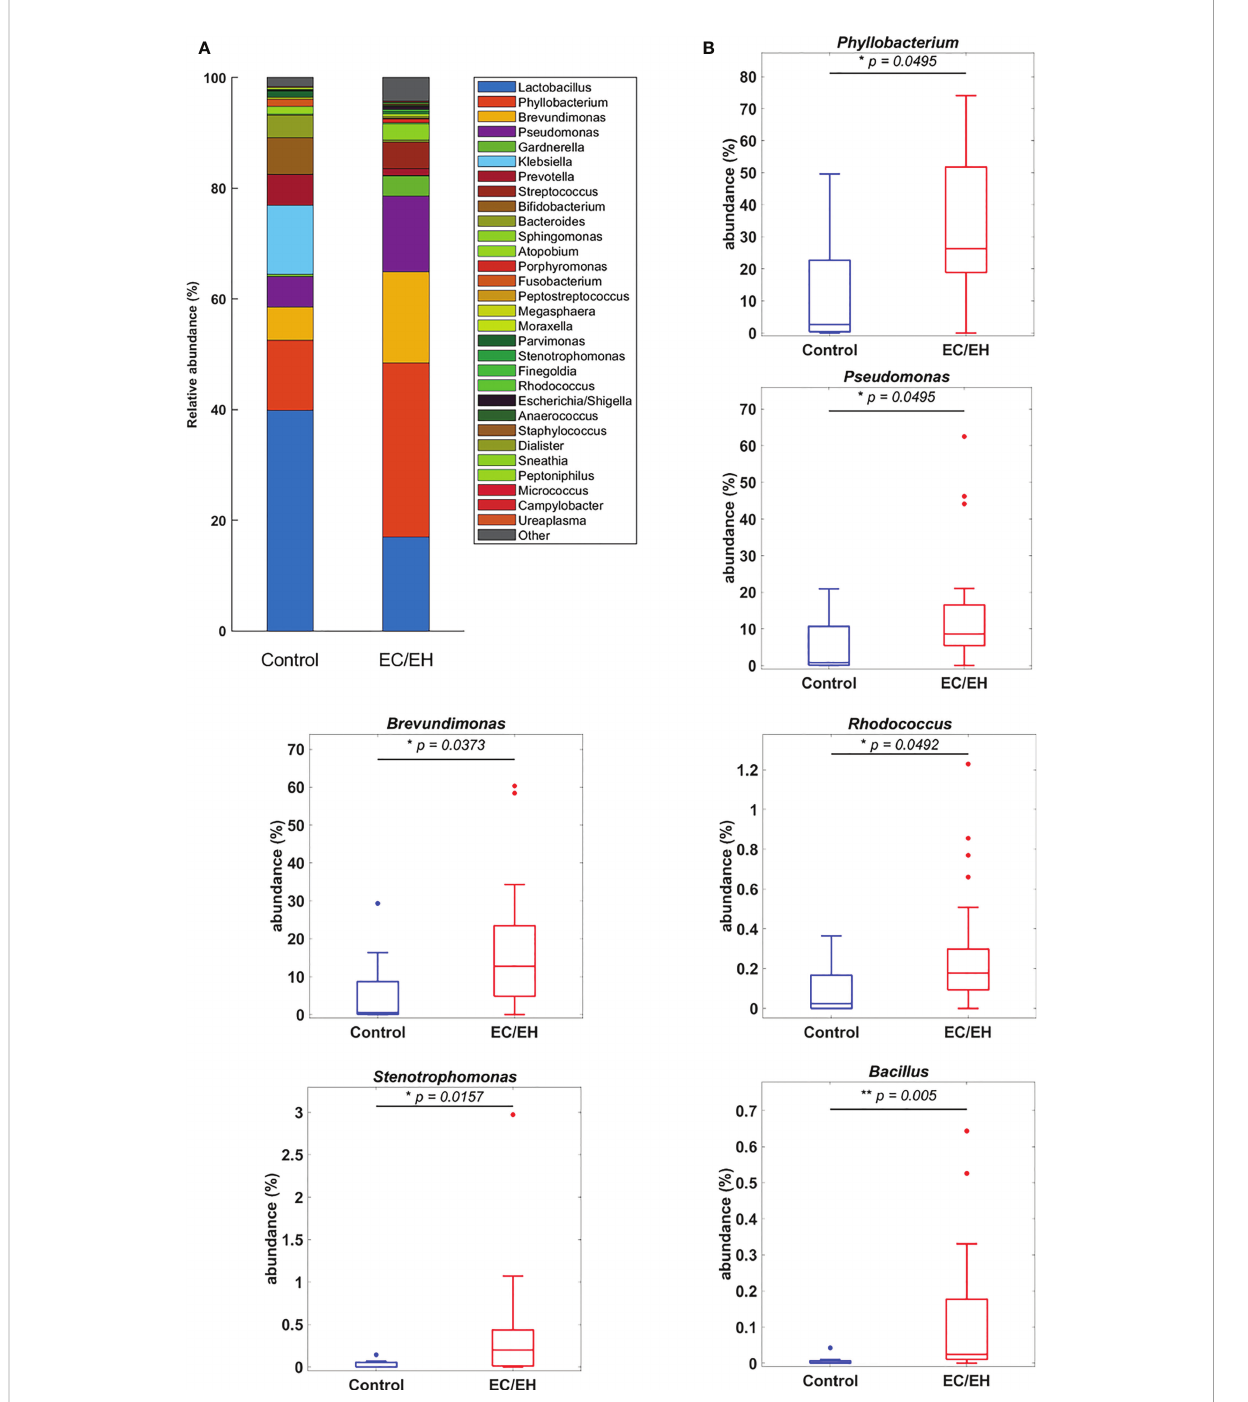
FIGURE 3 (A) Relative abundance of endometrial lavage bacteria in patients with EC/EH versus control women: taxonomic identi fi cation at the genus level. (B) Box plots revealed statistically signi fi cant intergroup differences in the relative abundance of the genera Phyllobacterium , Pseudomonas